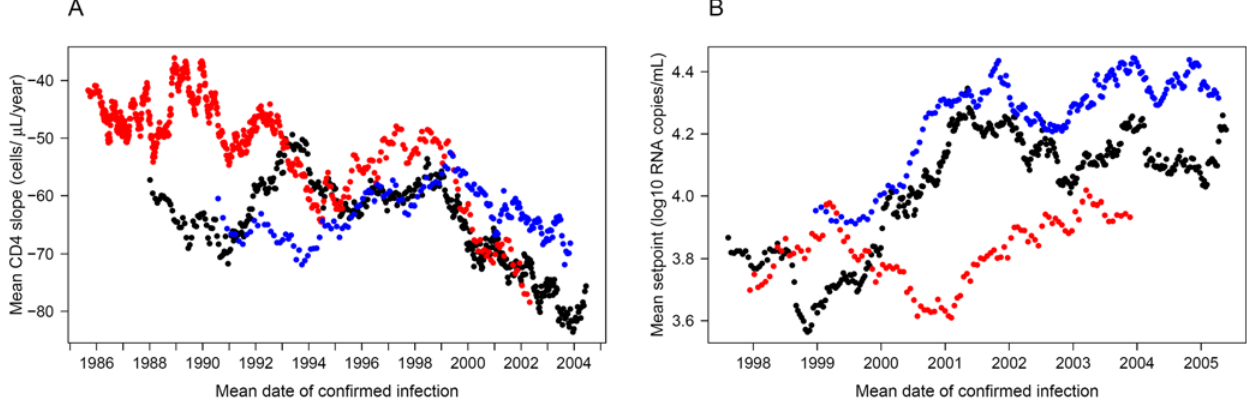
Figure 2. Moving averages of the CD4 slope and the viral setpoint per riskgroup. The figure shows time trends of the CD4 slope (A) and the viral setpoint (B) in the heterosexual (HET, black dots), intravenous drug-user (IDU, red dots), and men having sex with men (MSM, blue dots) exposure categories. This fine-scale representation suggests two stages in the time evolution of CD4 slopes within the riskgroups: in the first stage, IDUs lost their initial advantage of slower CD4 decline compared with HETs and MSM. After the convergence of the three categories, the second half of the observed epidemic has been characterized by a steady coupled trend towards steeper CD4 slopes in all groups. Trends in the viral setpoint seem to be strongly coupled between HETs and MSM with a recent deceleration of the increasing trend; the setpoint of IDUs seems to have fluctuated with no clear trend. Each point in the graphs represents the averaged value of 50 patients and is dated to their mean date of confirmed infection. The window of averaging moved along the list of patients sorted according to the date of confirmed infection: the first point represents the average of the first 50 patients, the second point represents the average calculated over the second through the 51 st patient, etc. The same datasets were used as in the multivariate regression analyses, i.e. outliers below the 5% and above the 95% quantiles were removed from the set of CD4 slopes.